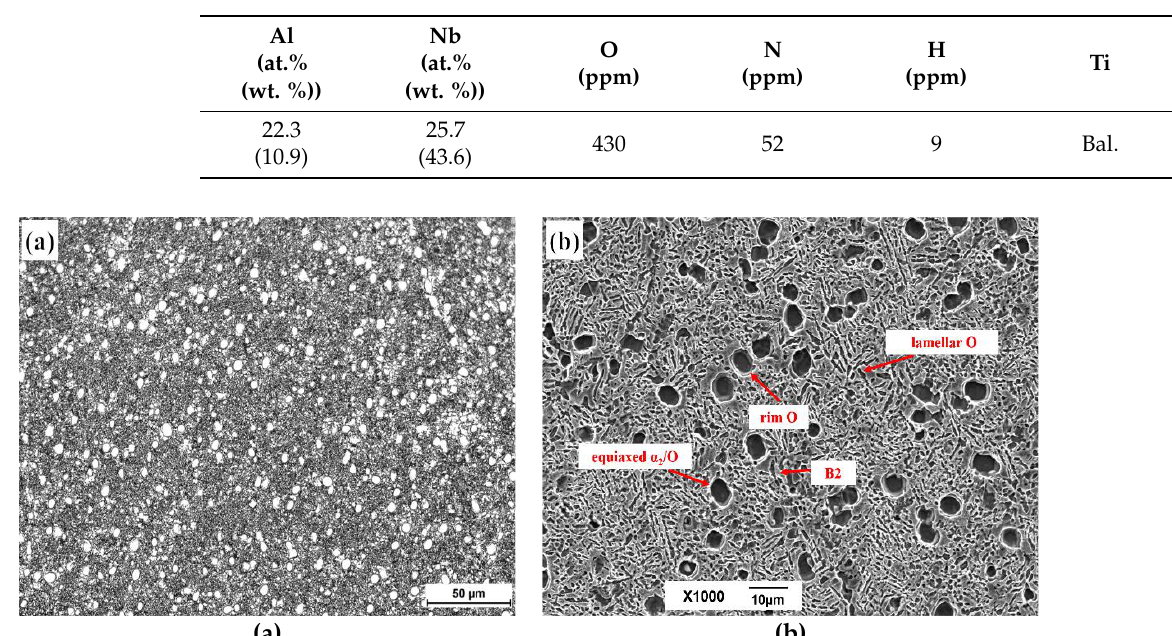
Figure 1. Microstructure of the as-received Ti-22Al-25Nb alloy: ( a ) LM, ( b ) SEM.